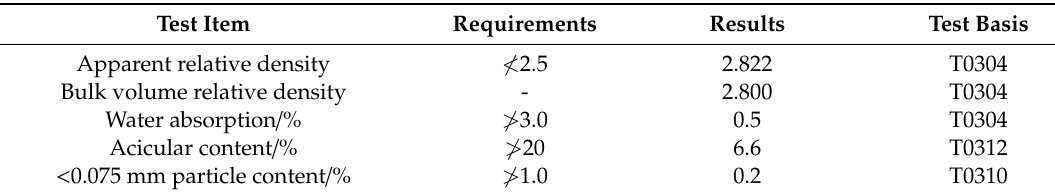
Table 3. Physical properties of granite.